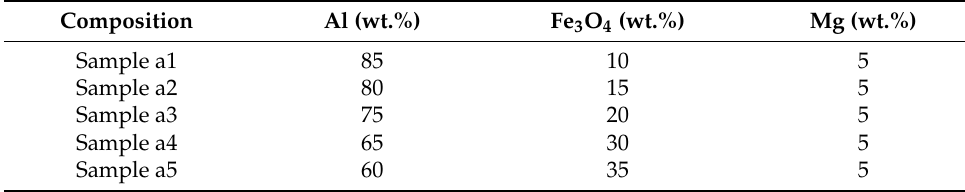
Table 1. Compositions of aluminium and magnetite composites.